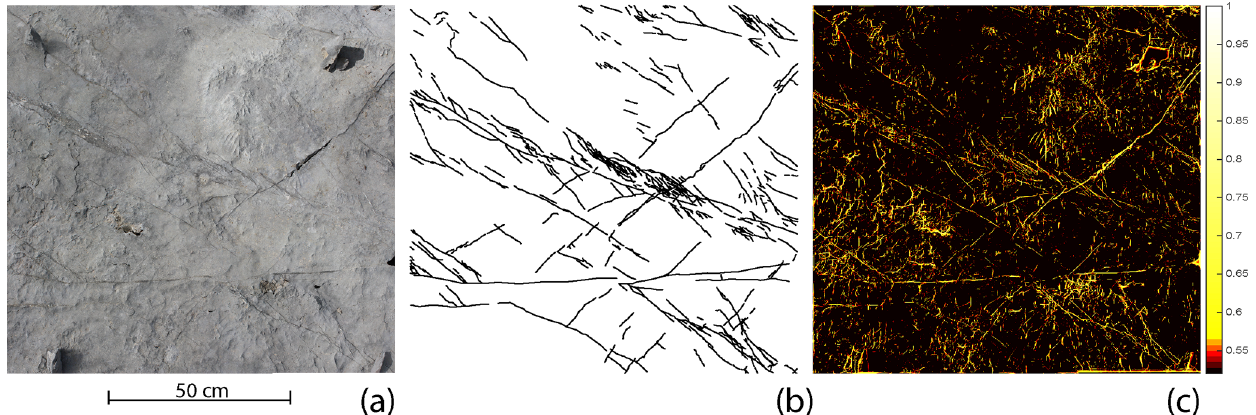
Figure 10. Extension of the automated method to extract mineralized fractures. (a) Image from Parmelan depicting mineralized fractures. (b) Manual interpretation of mineralized fractures. (c) Ridge ensemble.